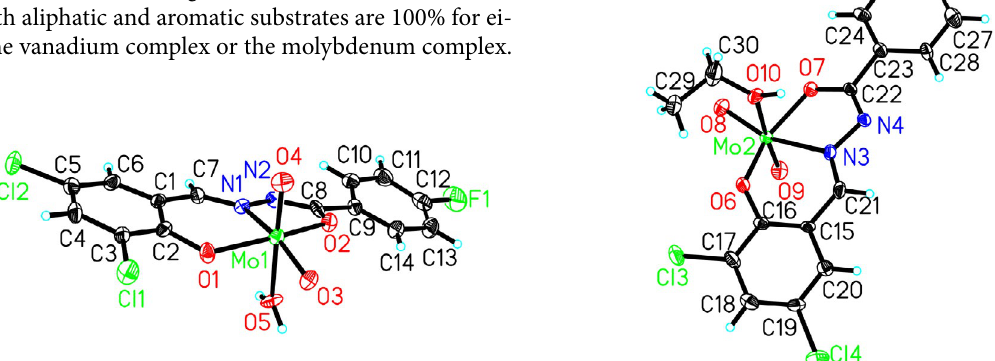
Fig. 3. Perspective view of complex 2 with the atom labeling scheme. Thermal ellipsoids are drawn at the 30% probability level.